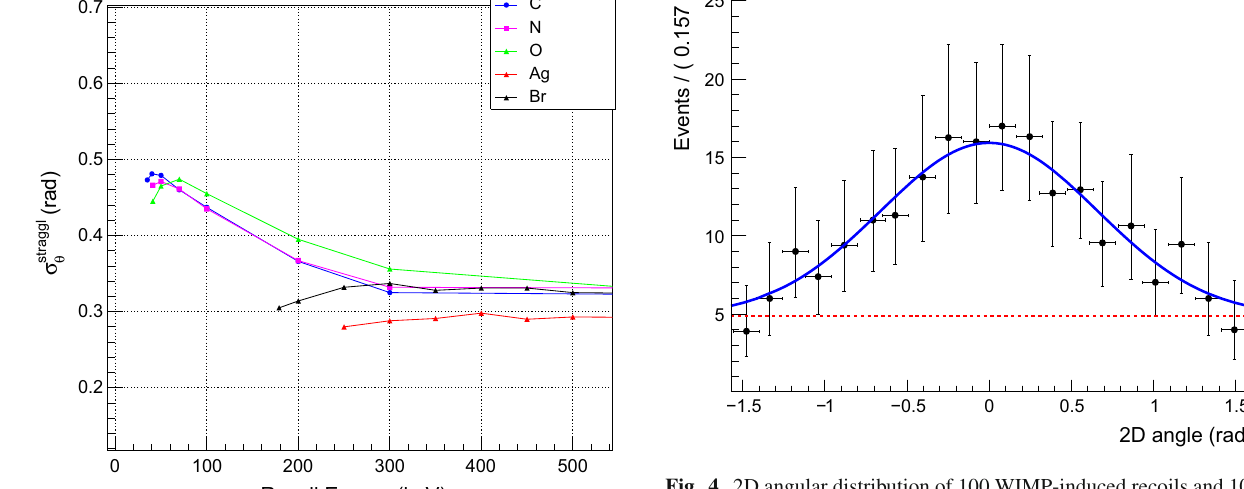
Fig. 4 2D angular distribution of 100 WIMP-induced recoils and 100 background events. Signal and background components are represented assolidblueanddashedredlines,respectively.Recoilsareproducedfor an emulsion target, a 40 GeV/c 2 mass WIMP and a 100 nm